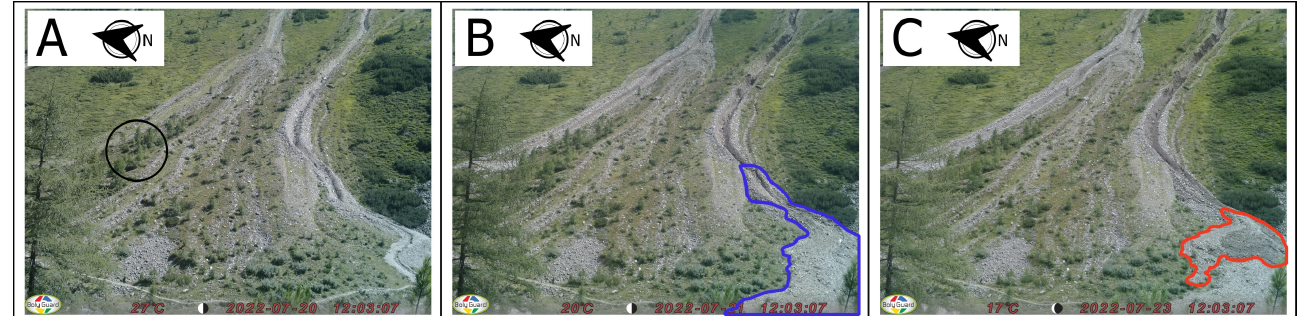
Figure 3. Photos taken by the camera in GT. ( A ): Pre-event photo from 20 July 2022. For scale: the encircled trees reach up to 10 m in height. ( B ): Photo after first event, dated 21 July 2022. ( C ): Photo after second event, taken on 23 July 2022.